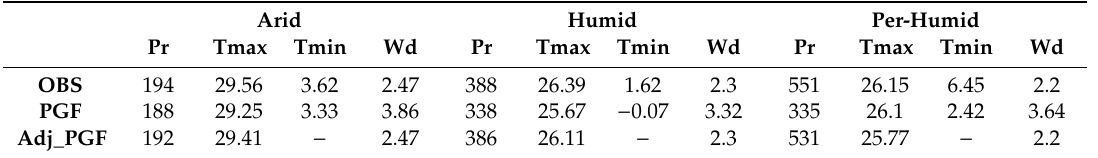
Table 4. Climate characteristics in the three climate zones from 1988 to 2012. Arid Humid